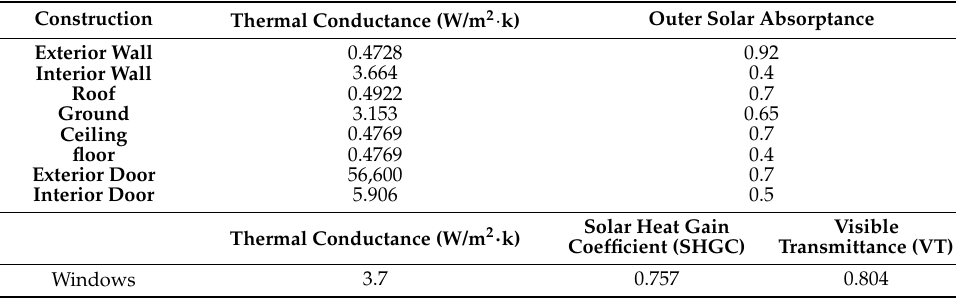
Figure 6. Three-dimensional model of the buildings in SketchUp. (Left to right: Building A, B, and C). Table 5. Input construction of the buildings in